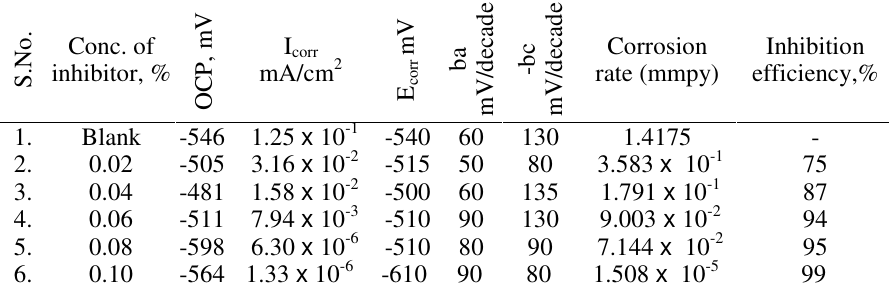
Table 3. Potentiostatic polarization studies for mild steel corrosion in sulphuric acid with AV Conc. of o . N S . 1. 2.